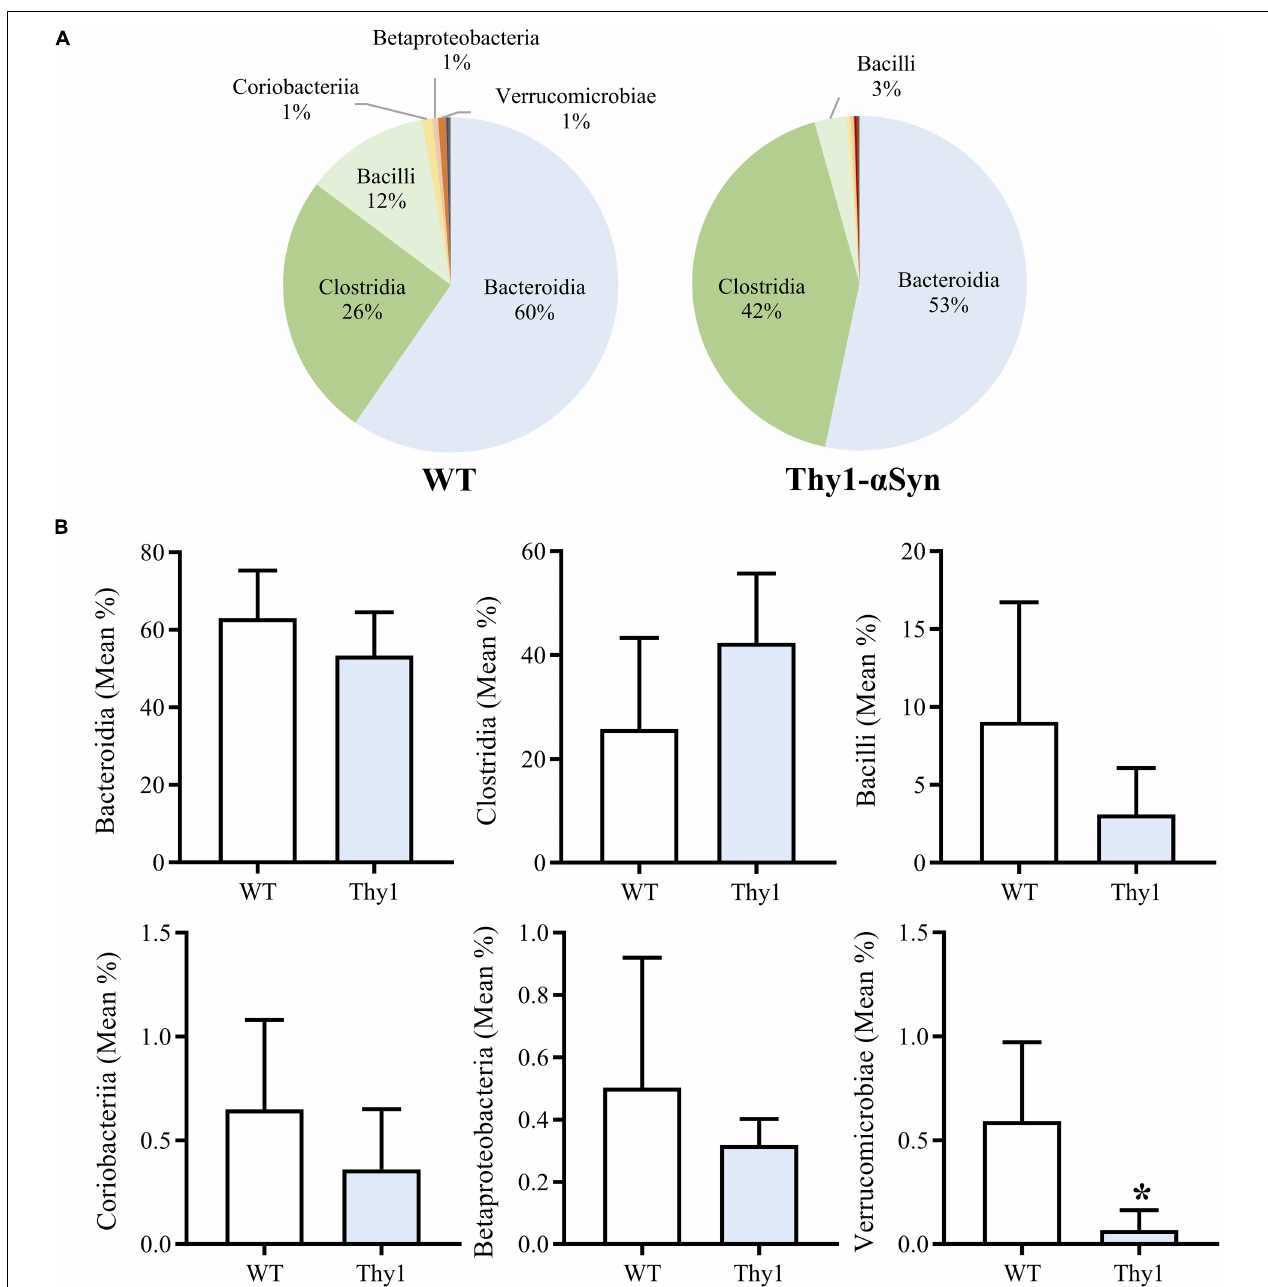
FIGURE 3 | Thy1- α Syn mice do not demonstrate a pro-inflammatory gut microbiome at 8 weeks of age. Bacteroidia, Clostridia and Bacilli account for the majority of the microbiome in both WT and Thy1- α Syn mice as per 16S rRNA sequencing at 8 weeks of age (A) . Thy1- α Syn mice exhibit a significantly lower abundance of Verrucomicrobiae, however, the mean relative abundance of Bacteroidia, Clostridia, Bacilli, Coriobacteria and Betaproteobacteria are not significantly different (B)